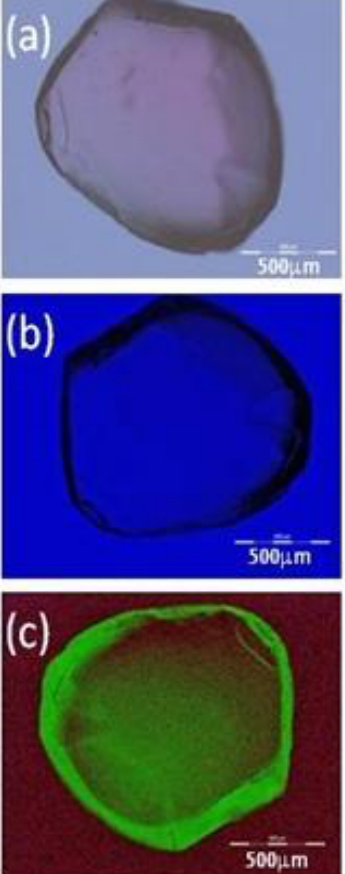
Figure 3. Images obtained using the Smartphone as optical source: (a) Optical image of hollow shell using all RGB components; (b) Optical image using just the blue component and (c) fluorescent image obtained by excitation with the blue and transmitting green